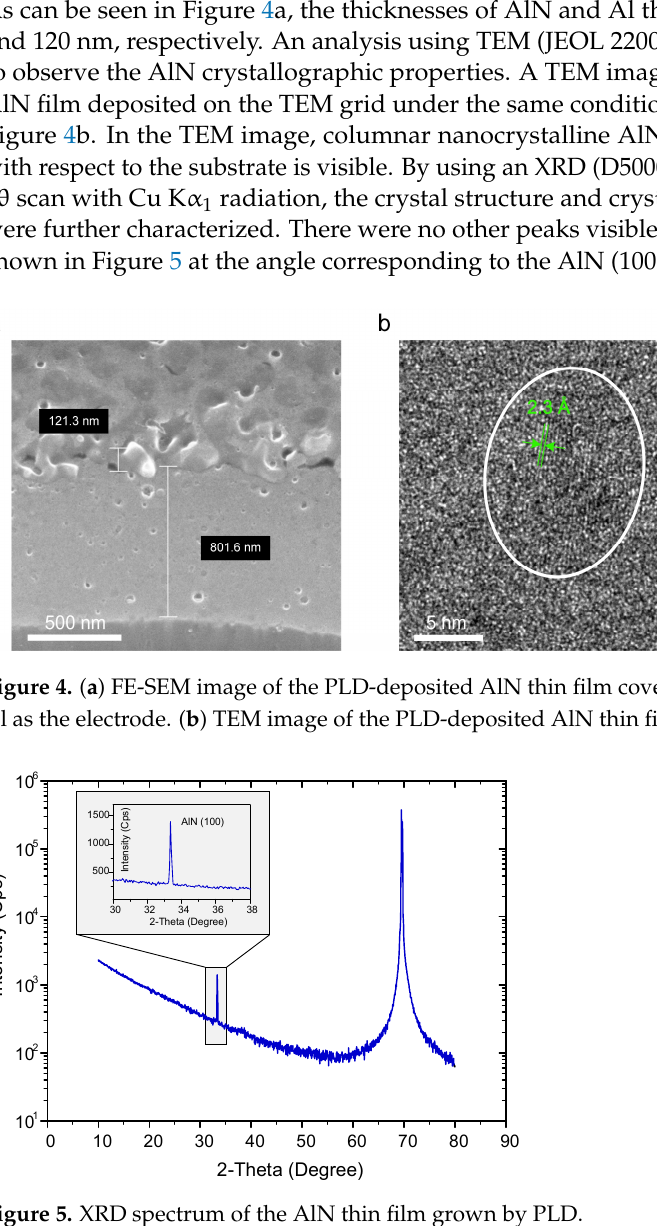
Figure 3. ( a ) Schematic illustration of AlN-PNG and ( b ) optical image of a bent AlN-PNG attached to a glass tube.